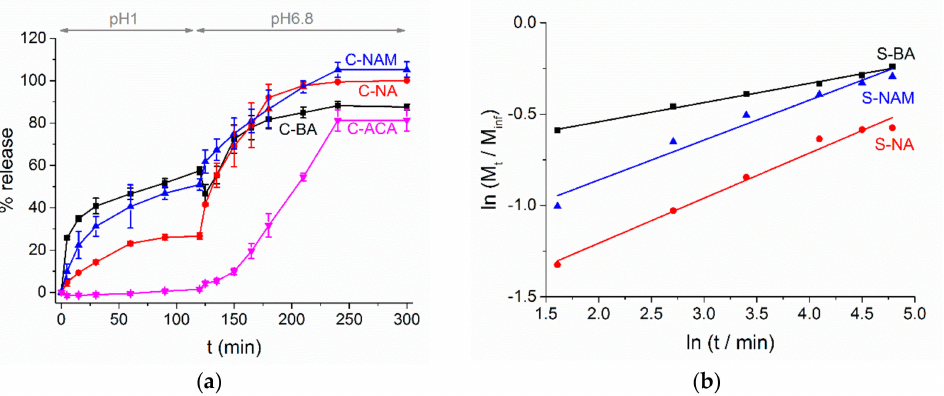
Figure 10. ( a ) AI release from the core/shell formulations, with data given as mean ± S.D. from three independent experiments; ( b ) fitting the Korsmeyer-Peppas model to the experimental data obtained at pH 1. Percentages are given relative to the theoretical AI loading in the fibers.